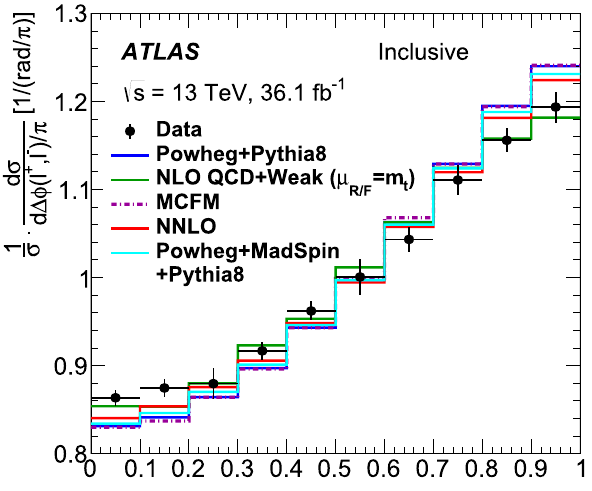
Fig. 13 Comparison of the unfolded (cid:3)φ distribution with theoretical predictionsforthenormalisedcross-sectionwiththeinclusiveselection. Each prediction is discussed in the text